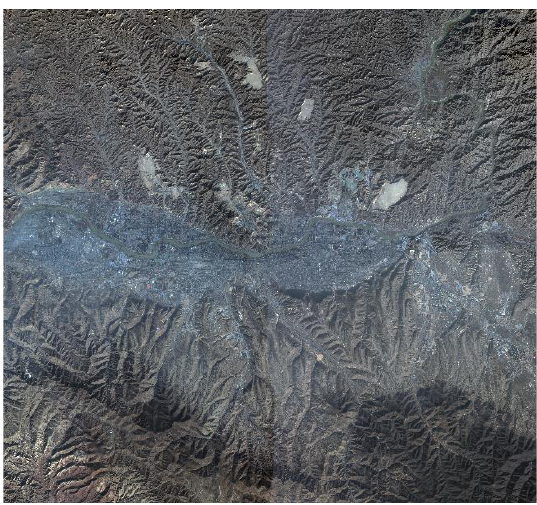
Figure 14. The original remote sensing image.